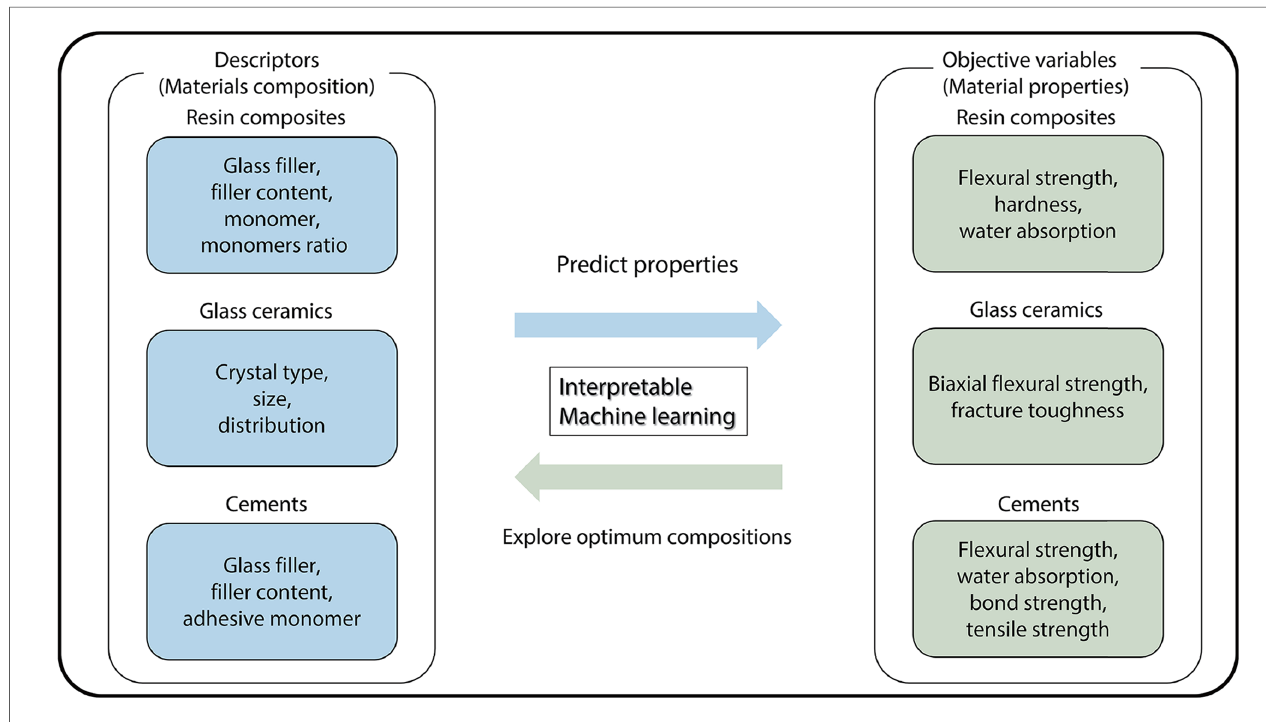
FIGURE 1 Schematic illustration of the materials informatics